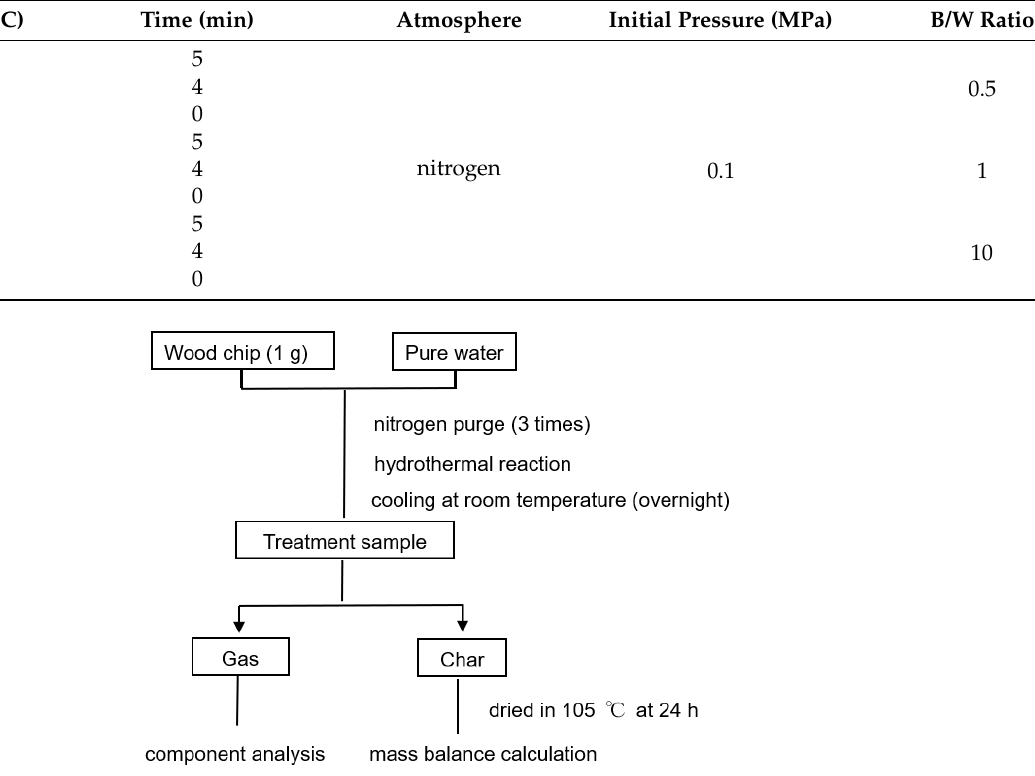
Figure 2. Experimental flow of HTG.